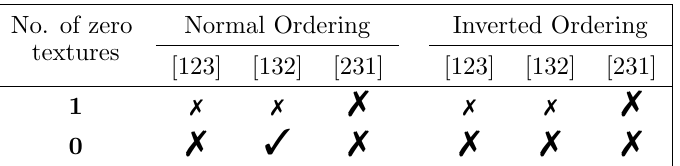
7 ) indicates 3 for